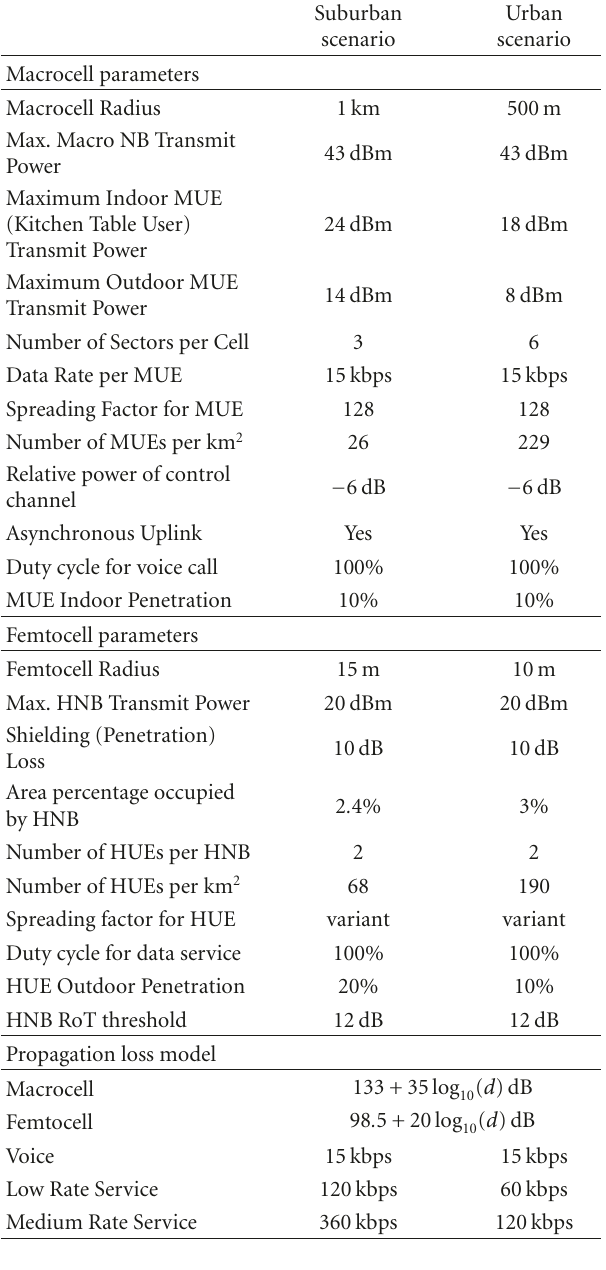
Table 1: System Parameter for Macro and